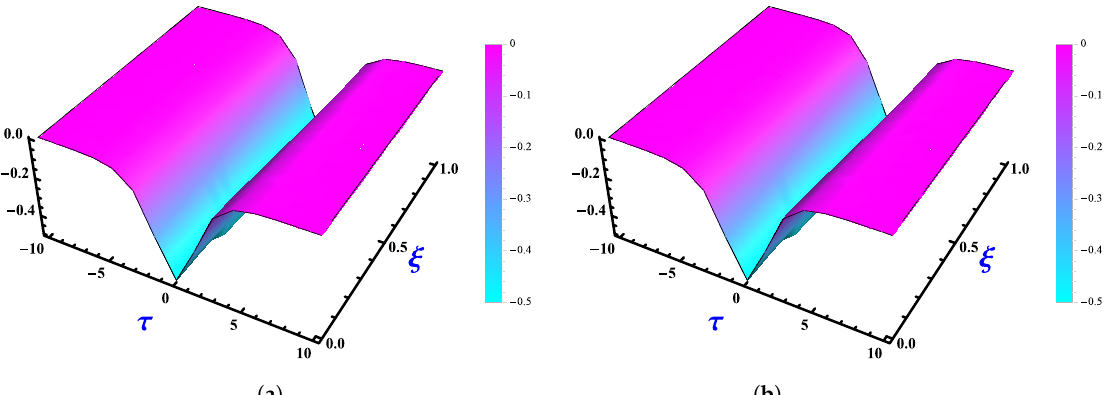
Figure 17. Two-dimensional plots of the numerical solu- tion at different α ’s values by using FNAM verses τ at time ( a ) ξ = 0.1 and τ ∈ [ − 2,2 ] , ( b ) ξ = 0.1 and τ ∈ [ − 10,10 ] , ( c ) ξ = 0.2 and τ ∈ [ − 2,2 ] and ( d ) ξ = 0.2 and τ ∈ [ − 10,10 ] for Example 4.